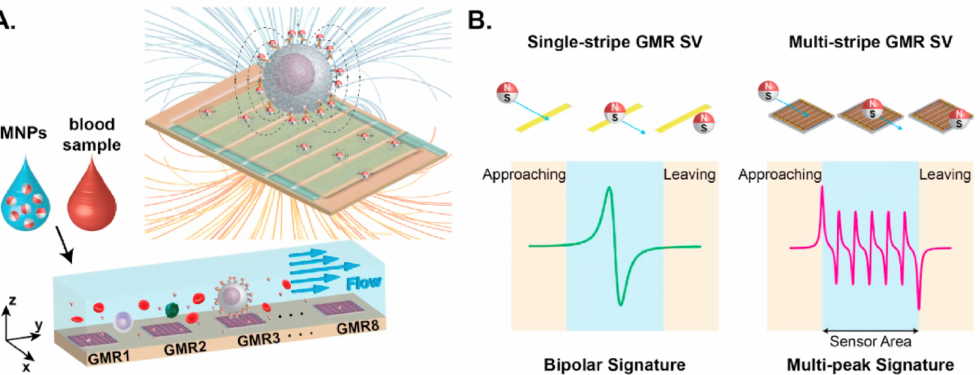
Figure 8. Magnetic flow cytometer (MFC) concept: ( A ). Operation of a GMR SV-based MFC where MNP decorated cells flow over GMR SV sensors. ( B ). Signature from conventional single-stripe sensors with a simple bipolar peak that increases the false detection events and the proposed multi- stripe configuration that enhances the signal differentiation by creating a unique magnetic signature. Reprinted from [82] with permission of Elsevier provided by Copyright Clearance